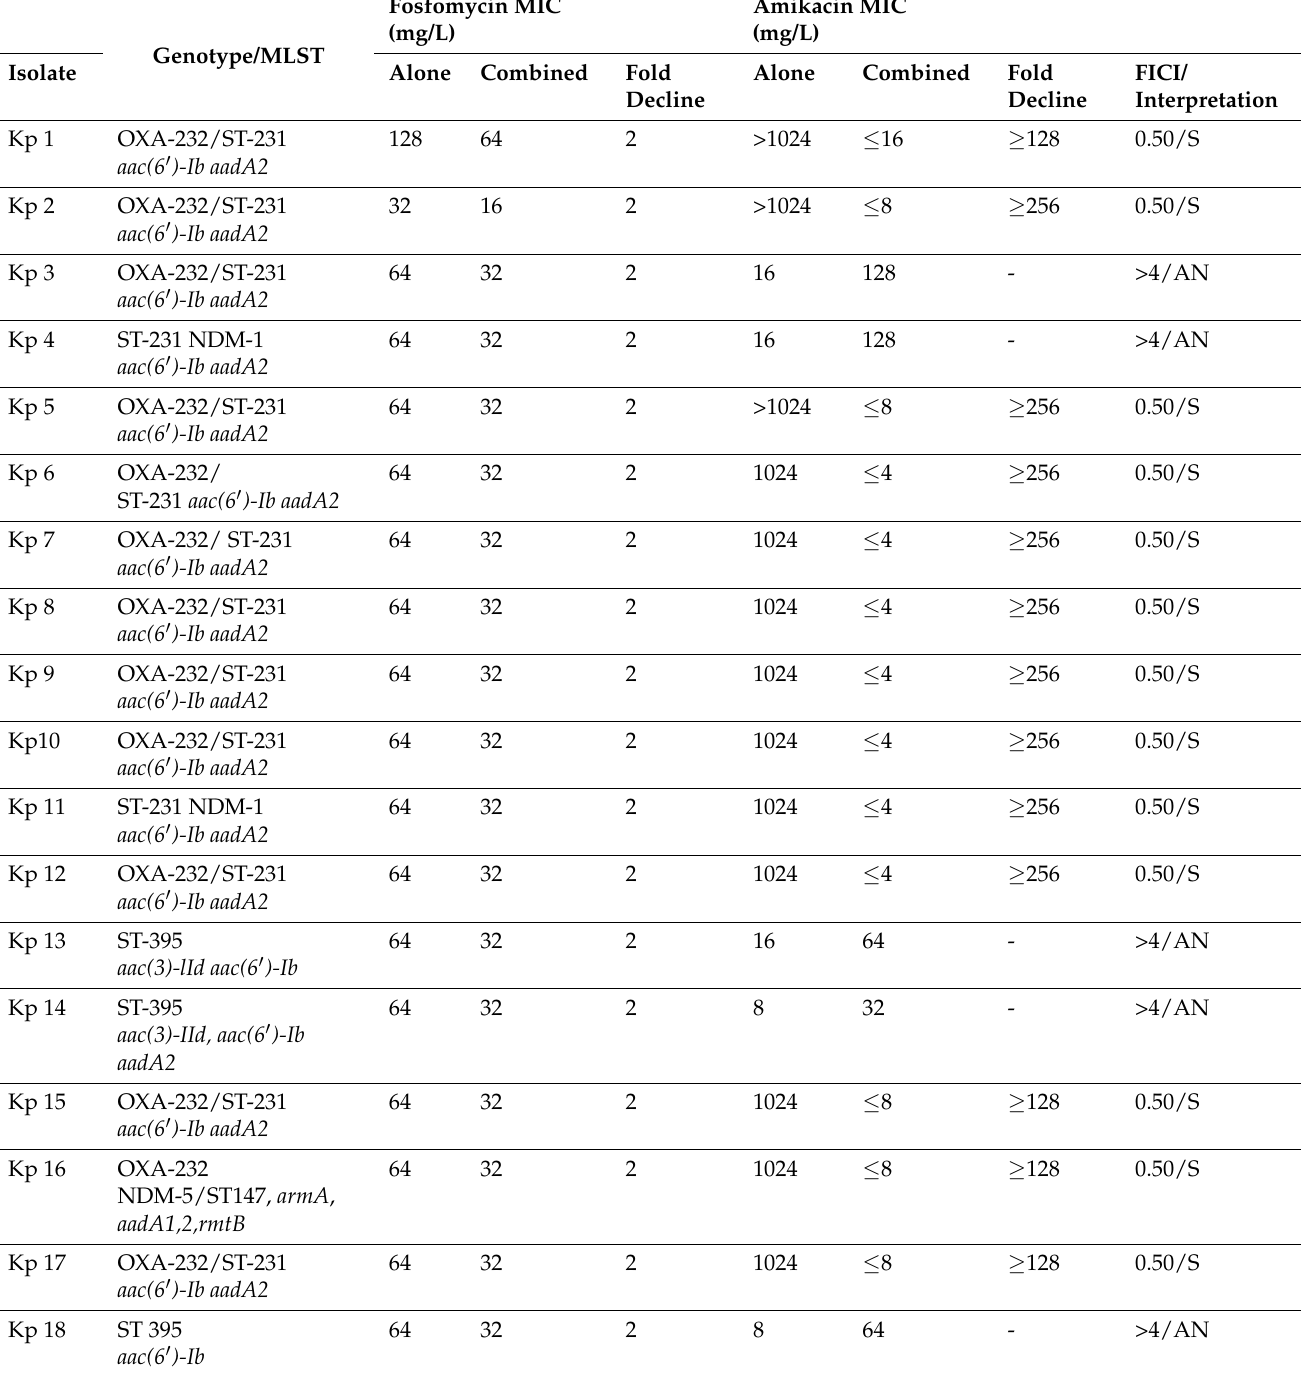
Table 4. Synergy outcomes of fosfomycin-amikacin combination using the Checkerboard